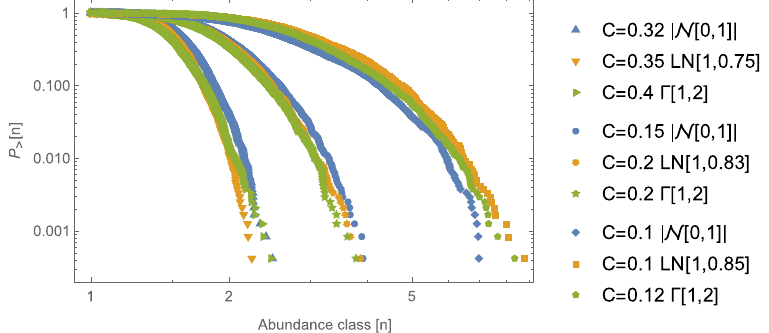
Figure 2. Cumulative RSA for a network of 300 species. The matrix elements of both M and L have been ij ij drawn from three different probability distributions ( ~ z p z ( ) , ~ M z , ~ L z , − ~ L z , = h 1, 2, 3 ): the h h ij h ij h ji h (green lines) modulus of a Normal distribution  α β | | ~ z ( , ) 1 (blue lines), Gamma distribution α β Γ ~ z ( , ) 2 and LogNormal distribution α β ~ z LN ( , ) (orange lines). Connectivity for mutualistic interaction, M , is 3 = , while for exploitative interactions, L , is denoted by = . C C 0 1 denoted by C C (in all the studied cases M L + ≥ C C 1 ). The cooperative and exploitative intensities are   = = 1 . We set the distribution parameters M L 1 2 α β , (see legend) so that in each case we build interaction matrices with three different values of coefficient of variation ≈ CV 2, 3, 4 . Log-log plots display the relative species abundances (RSA) from the stationary solution of Eq. (1) averages over 100 realizations and normalized so that the smallest population is 1. As we can see, the cumulative RSA is not very sensible to the distribution from which the matrix elements of both M and L are ij ij drawn, but only on the